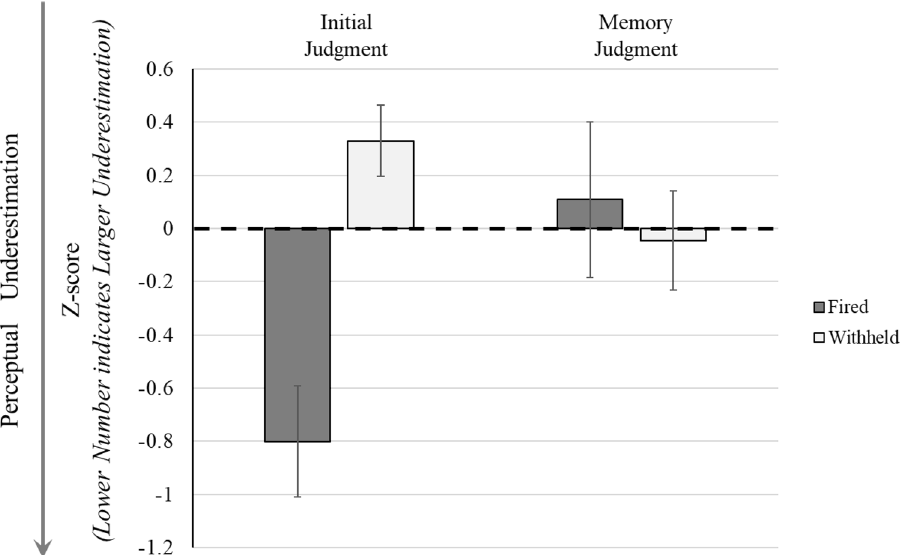
Figure 3. Perceptual differences from the stress-inoculation event between individuals who fired upon an unarmed person in the pre-training exercise and individuals who did not fire on an unarmed person (dark gray bars, fired; white bars, withheld ). Left half of the figure indicates perceptual underestimations for the initial judgment, and the right half indicates perceptual underestimations for the memory judgment. Y-axis is the z-score combined situational awareness metric as averaged across the three components (temporal, threat, pain). Lower scores indicate a larger underestimation relative to the actual event. Error bars show ± 1 standard